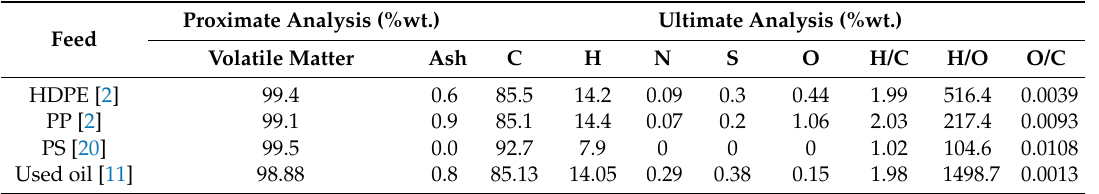
Table 2. Feedstock